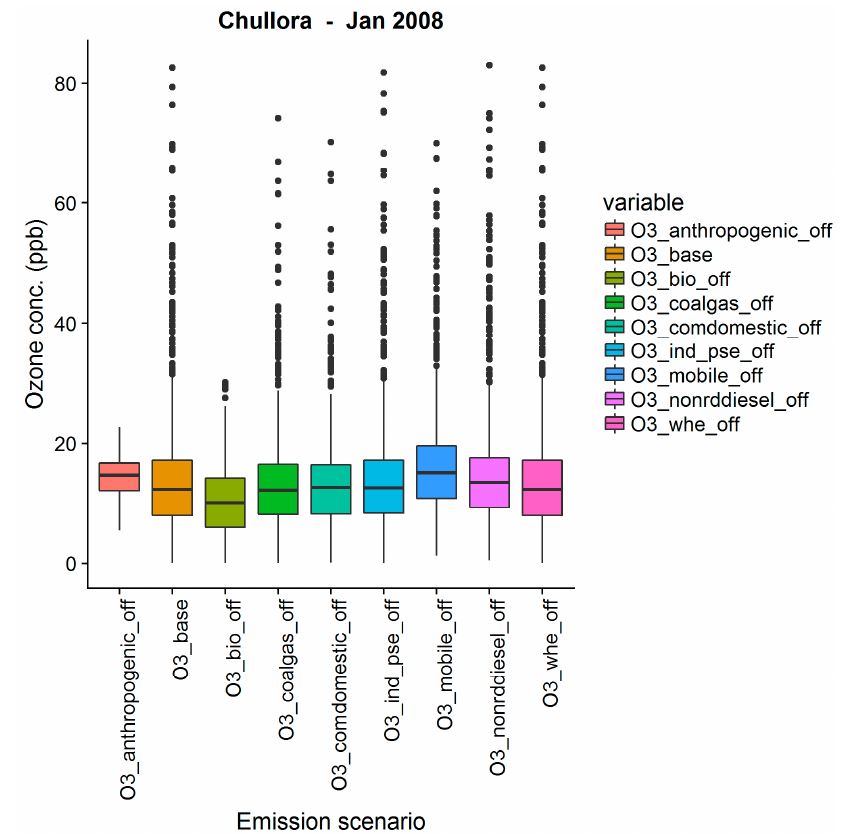
Figure A6. Box plot for 1-h ozone concentration (ppb) in January 2008 under different emission scenarios at Chullora.